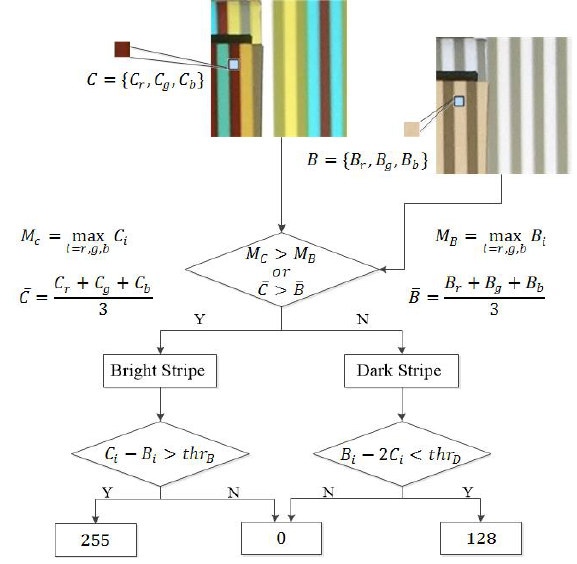
Figure 7. Flow of recovering the original color of color stripes.